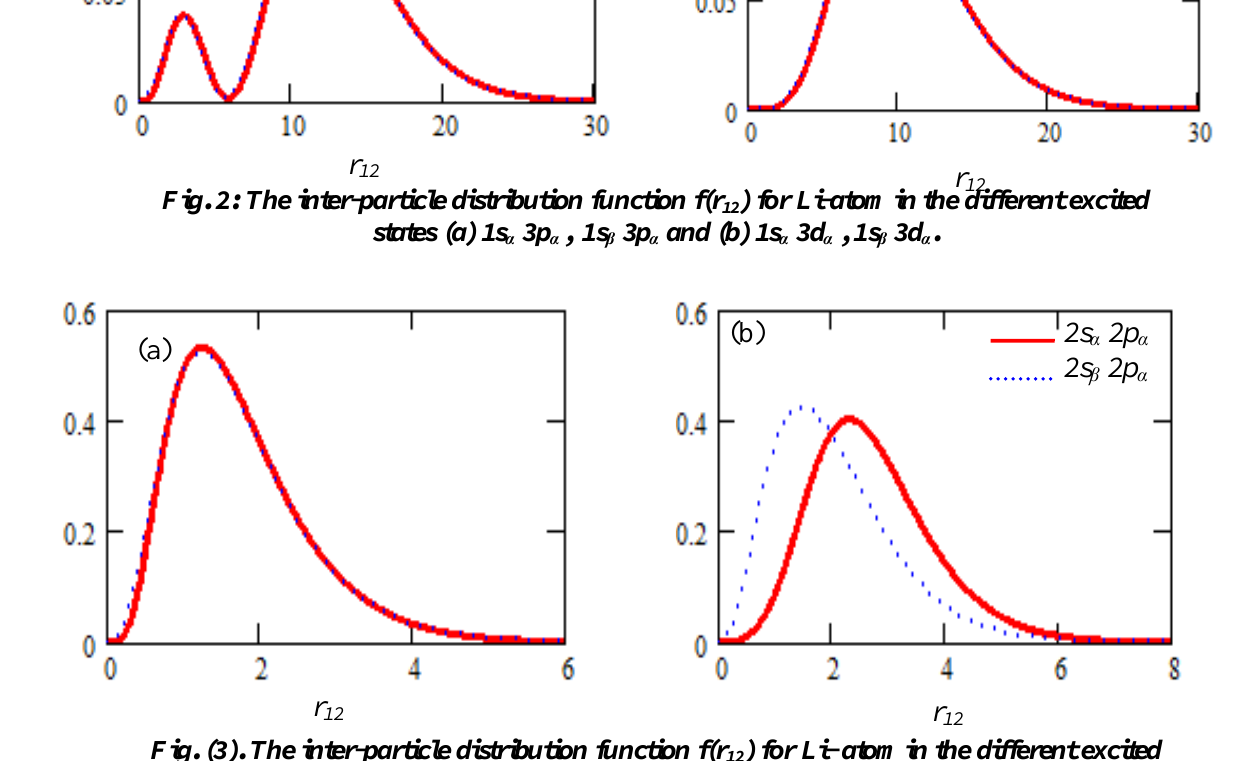
) for Li- atom in the different excited 12